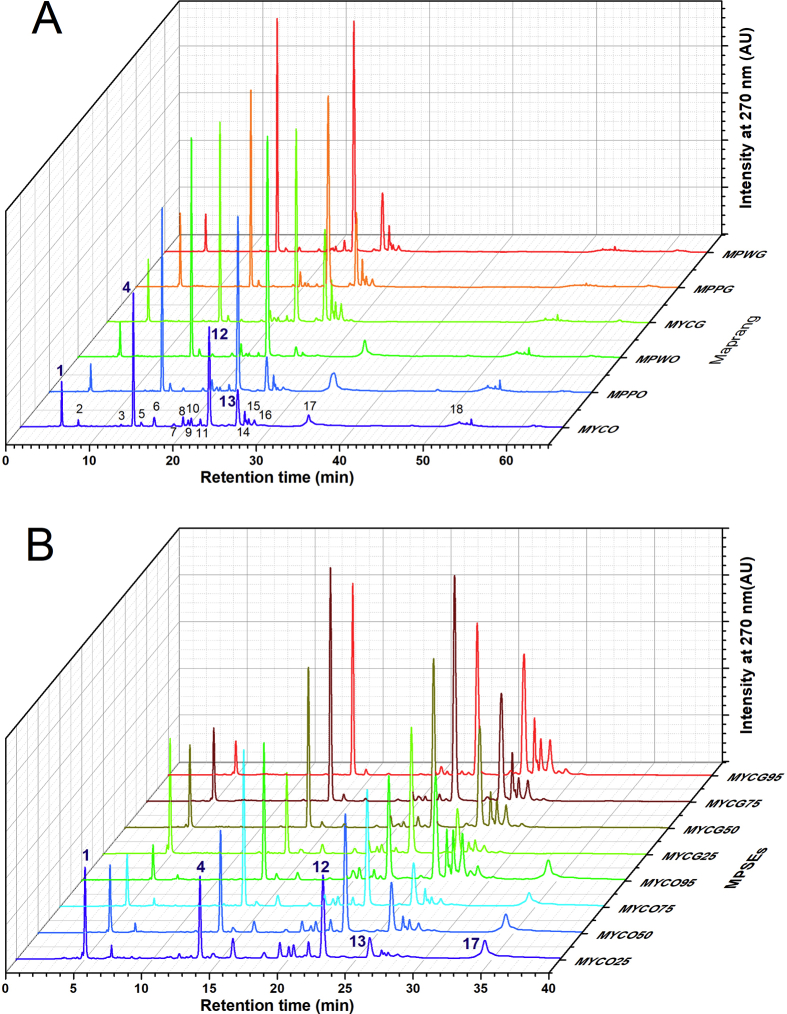
(A) HPLC fingerprints of maprang flavonoids obtained from maprang wan (MPWG & MPWO), maprang prieyo (MPPG & MPPO) and mayong chid (MYCG & MYCO). (B) HPLC fingerprints of maprang flavonoids obtained from green and ripe mayong chid seed extracts using various solvent extraction systems. MPSEs, Maprang seed extracts; G, Green (unripe fruit); O, Orange (ripe fruit); MPW, Maprang wan; MPP, Maprang prieyo; MYC, Mayong chid; MYCG25, MYCG50, MYCG75, and MYCG95: 25%, 50%, 75% and 95% Ethanolic seed extract of MYCG, respectively; and MYCO25, MYCO50, MYCO75, and MYCO95: 25%, 50%, 75% and 95% Ethanolic seed extract of MYCO, respectively.